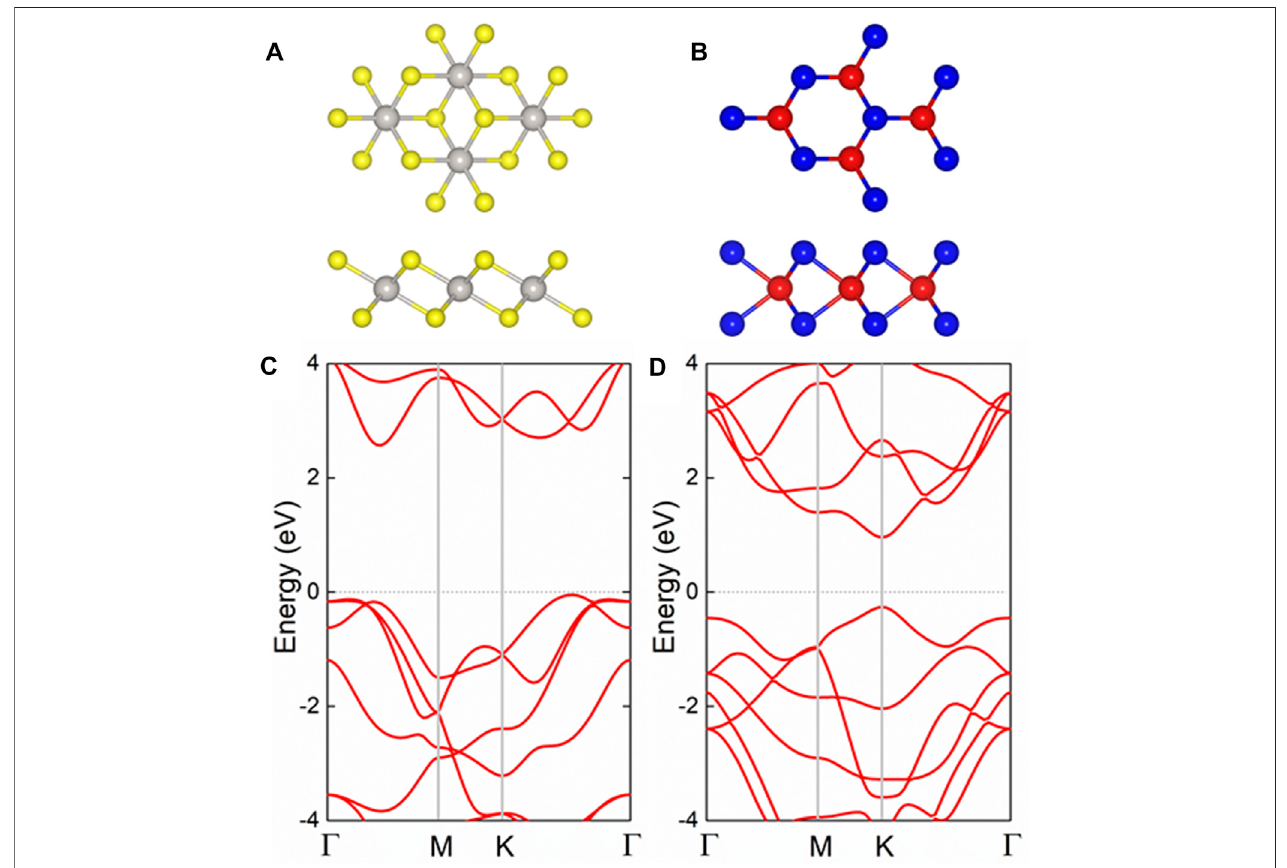
FIGURE 1 | The (A,B) geometric and (C,D) band structures of the pristine (A,C) PtS 2 and (B,D) MoTe 2 monolayers; the yellow, gray, red, and blue balls represent S, Pt, Mo, and Te atoms, respectively; the Fermi level is expressed as 0 using gray dash line.